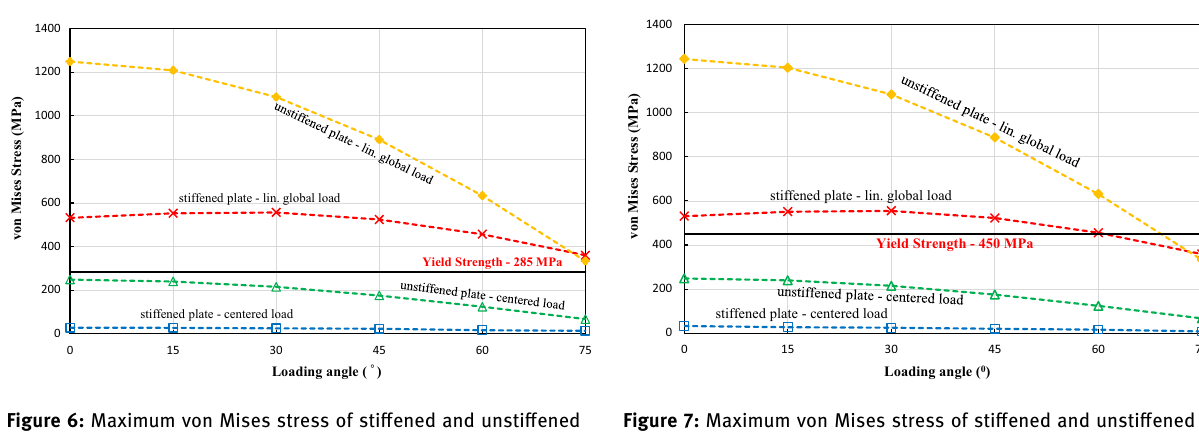
Figure 7: Maximum von Mises stress of sti ff ened and unsti ff ened medium - carbon steel